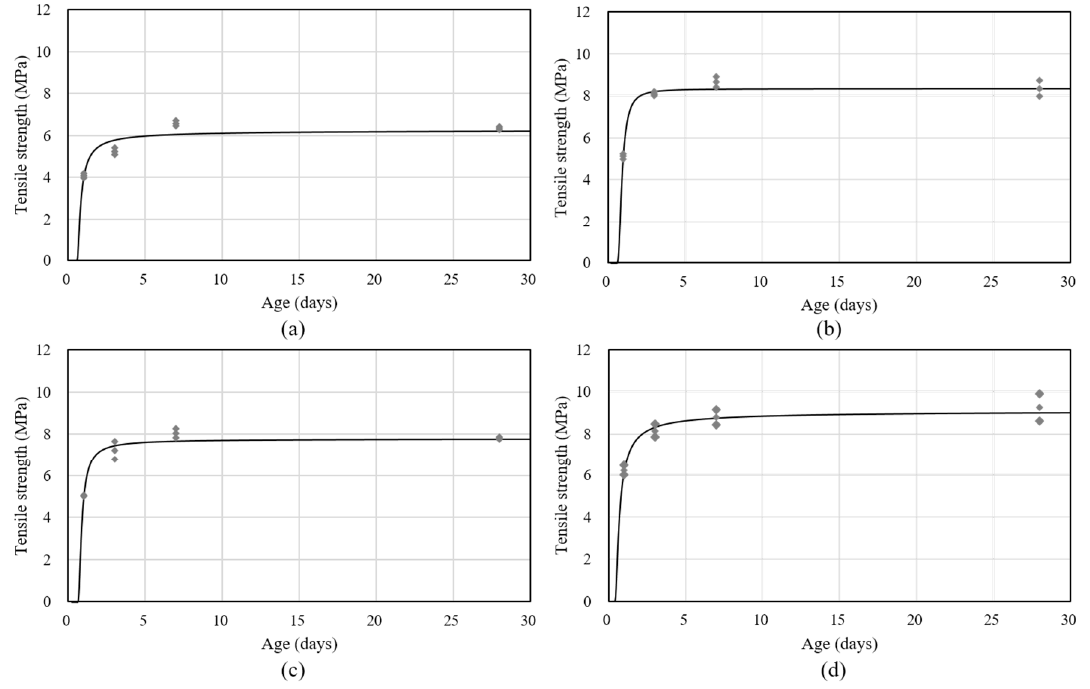
Figure 4. Tensile strength development of the HPC; ( a ) 0.0E-0.0R, ( b ) 5.0E-0.0R, ( c ) 0.0E-1.0R, and ( d )